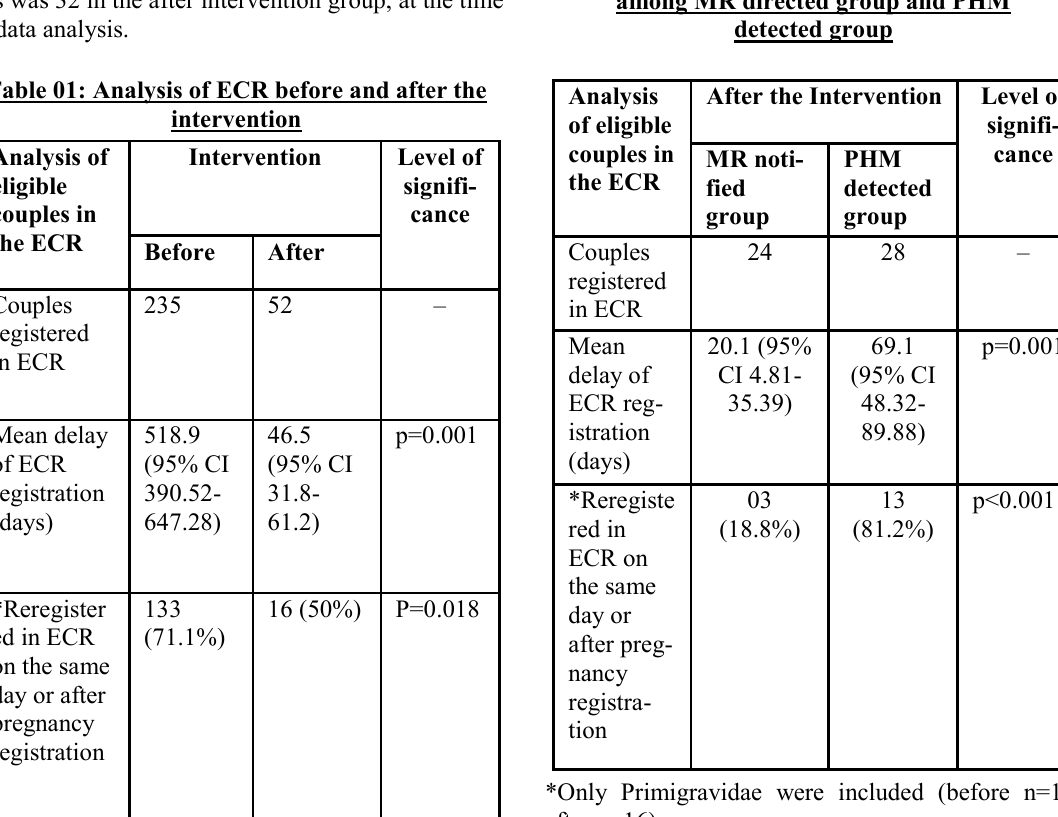
Table 02: Analysis of ECR after the intervention among MR directed group and